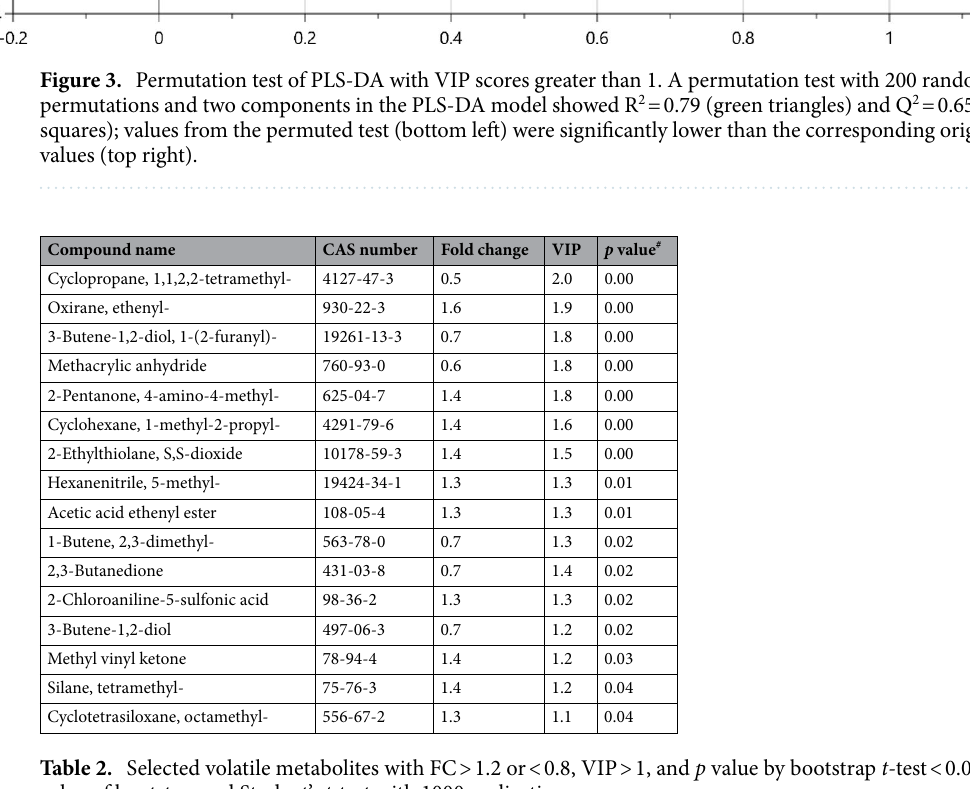
Table 2. Selected volatile metabolites with FC > 1.2 or < 0.8, VIP > 1, and p value by bootstrap t- test < 0.05. # p value of bootstrapped Student’s t -test with 1000